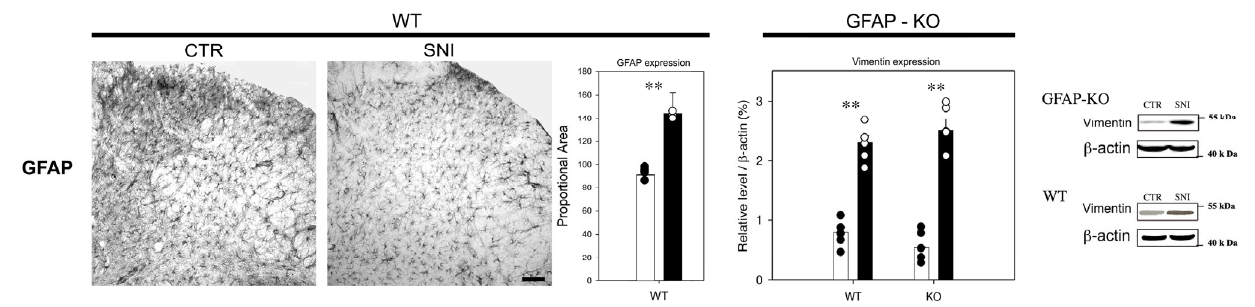
Figure 2. Microglial Iba1 expression in the dorsal horn of the spinal cord. Iba1 expression increased after SNI in both WT and KO animals. Iba1 level detected in CTR-KO animals was higher than that in CTR-WT mice (magnification 10 × ; scale bar, 50 µ m). Inset : higher magnification (40 × ) view of microglial cells, showing morphological features in CTR and nerve-injured mice (scale bar, 50 µ m). (Data are expressed as the mean ± SEM with individual data points; ** p ≤ 0.001; * p ≤ 0.01.).